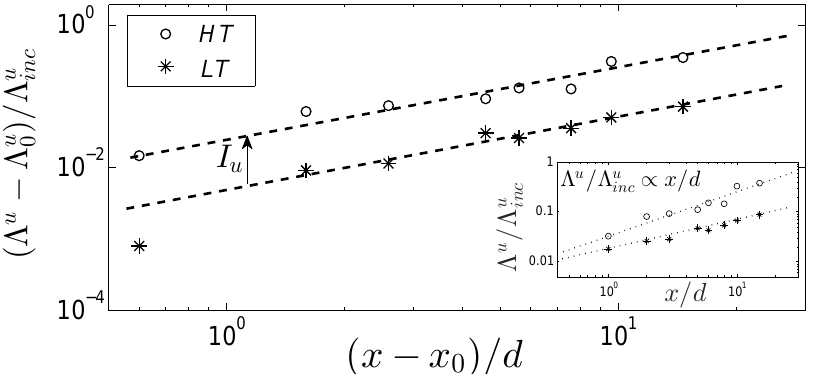
Figure 8. Log–log illustration of the integral length scales along the rotor axis between the HT and LT cases, highlighting the linear relation of the differences with distance. Here, x 0 / d ∼ 1/8 denotes the = Λ u = Λ u location where Λ u LT HT 0